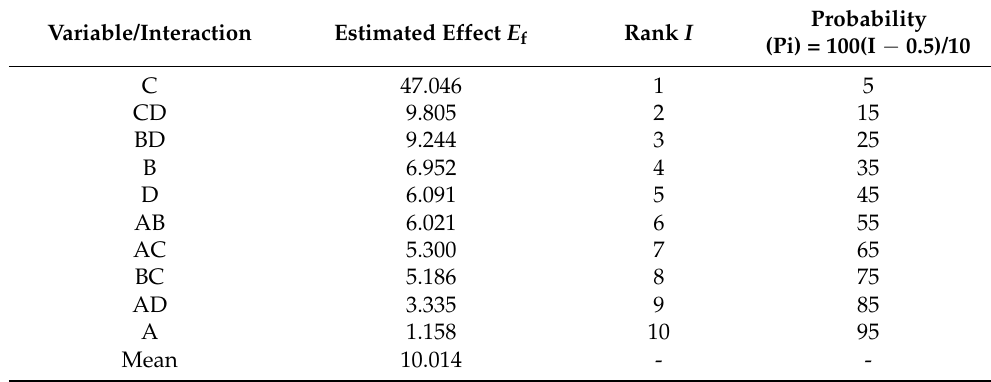
7 Table 4. Normal probability calculations. Variable/